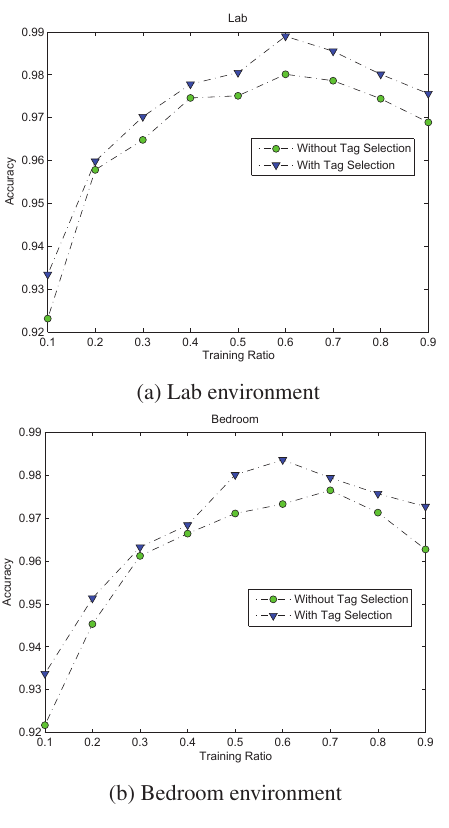
Figure 14: Accuracy comparison with and without tag selection using different training sizes: (a) lab and (b) bedroom performed posture classification over a series of posture transitions and measured how accurately our approach can recognize a posture given new coming RSSI values, as well as how timely our approach can recognize the posture.